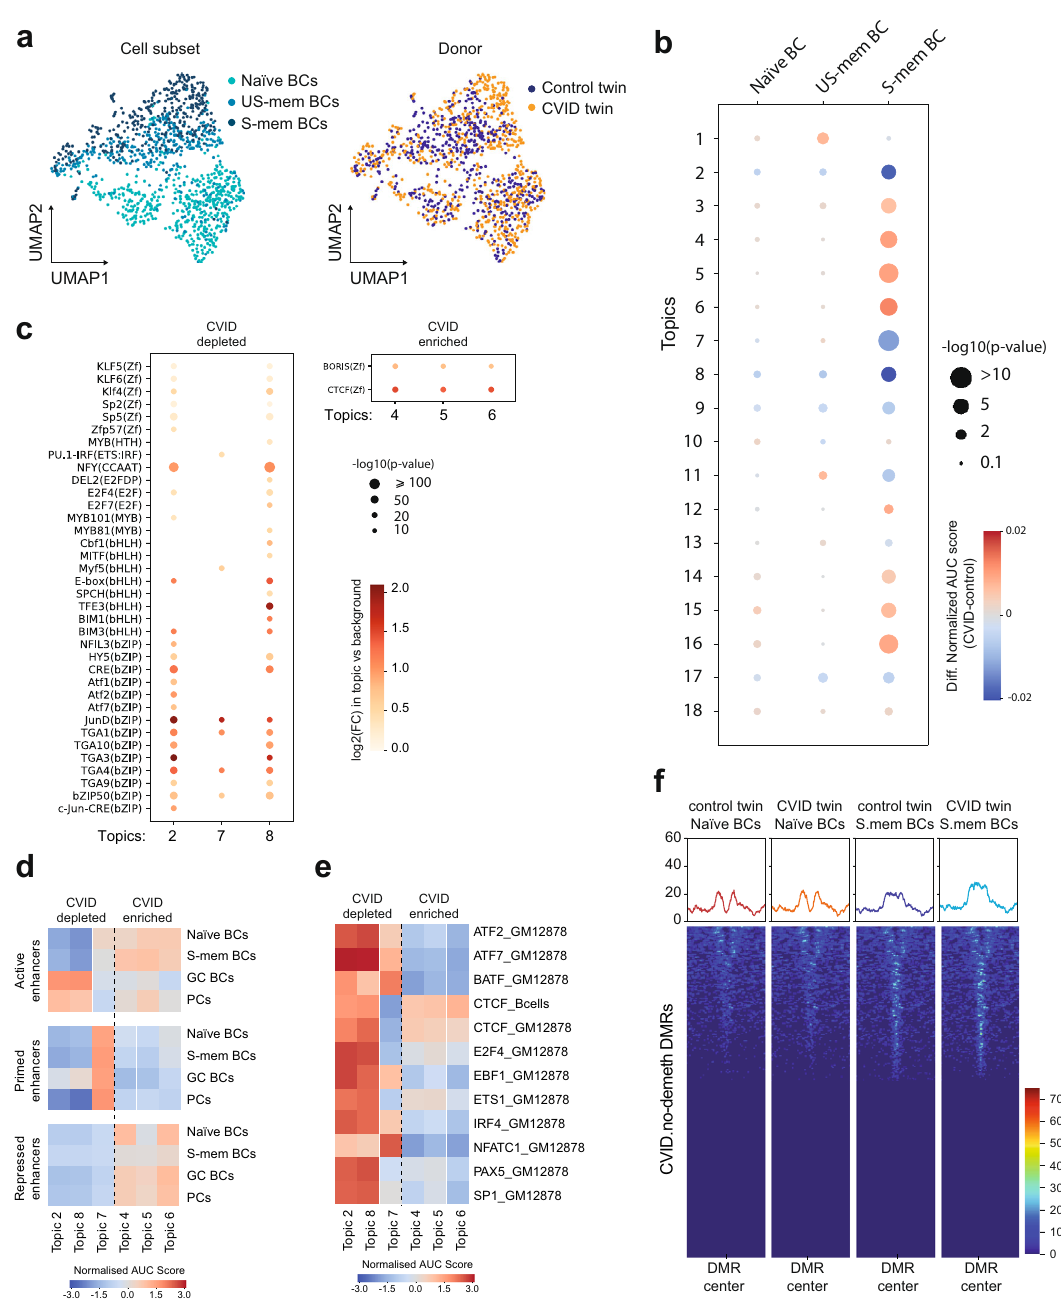
Fig. 3 Chromatin accessibility defects in CVID. a UMAP visualization of unsupervised analysis of chromatin accessibility in naïve, US-mem and S-mem B cells from the control and CVID twin (1179 cells) indicating the B-cell subset and the origin of the cell. b Heatmap representing the difference in normalized AUC scores for the different regulatory topics de fi ned by CisTopic between CVID and control twins in the B-cell subsets analyzed. Red color corresponds to a stronger association of the topic with the CVID twin; blue corresponds to a stronger association of the topic with the control twin. Circle size indicates the signi fi cance of the association (Mann – Whitney test). c Dot plot representing the signi fi cantly enriched TF binding motifs in selected topics that are most closely associated with chromatin accessibility in control twin (CVID-depleted: topics 2, 7, and 8) or most associated with chromatin accessibility in the CVID twin (CVID-enriched: topics 4, 5, and 6). d Heatmap representing the association of the CVID-depleted and CVID-enriched topics with different enhancer stages during B-cell activation (active, primed and repressed enhancers). Active enhancer regions were de fi ned for the concurrence of H3K4me1 and H3K27ac, repressed enhancers by H3K4me1 and H3K27me3, whereas primed enhancers by H3K4me1 exclusively. e Heatmap showing the association of CVID-depleted and CVID-enriched topics with several TFs binding signal in human immortalized B cells and CTCF in human primary B cells. f Heatmaps and histograms representing chromatin accessibility signals in naïve and S-mem B cells at CVID.no-demeth DMRs ± 2.5 Kb fl anking regions in control and CVID twins. Source data for panels in this fi gure are provided in the Source Data Fig. 3 fi